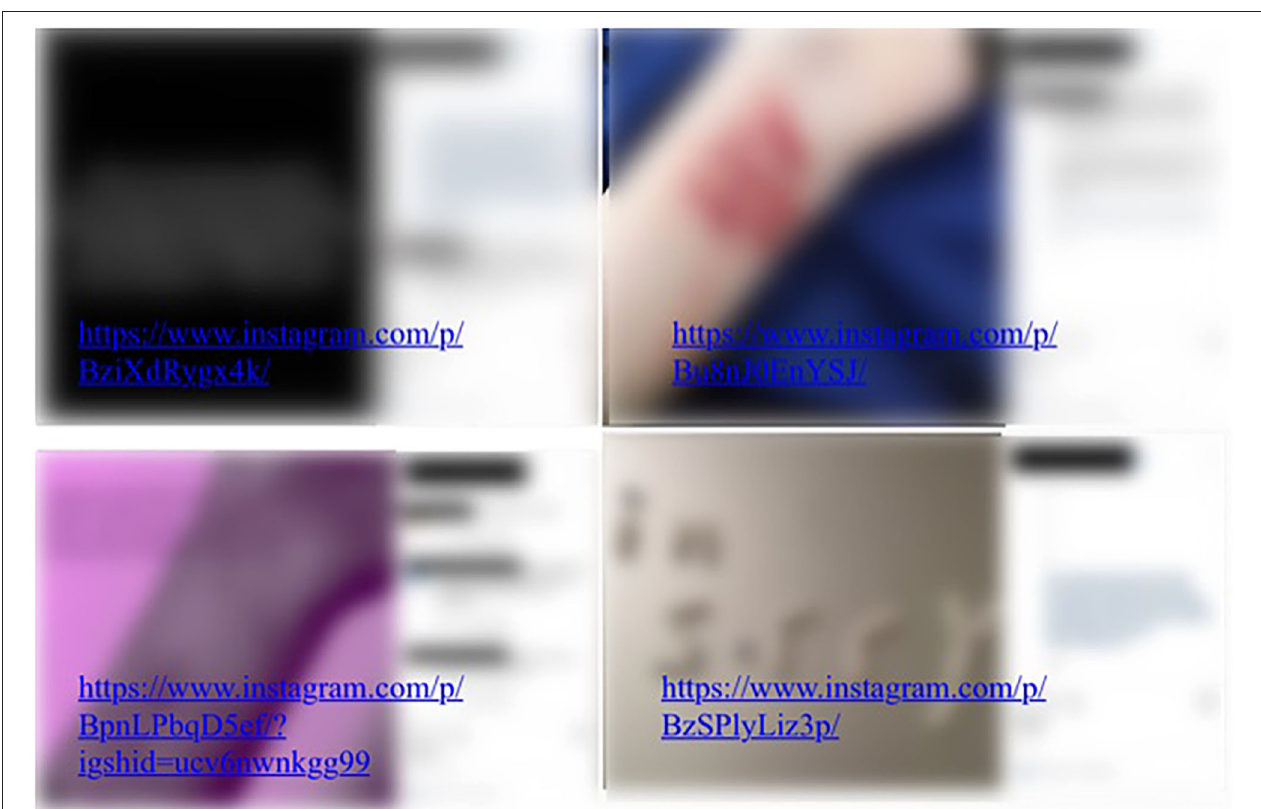
FIGURE 1 | Instagram posts with signal for suicide/self-harm, mental health problems and drug abuse (user information concealed and images blurred). If you’re thinking about suicide, are worried about a friend or loved one, or would like emotional support, please contact the National Suicide Prevention Lifeline at 1-800-273-TALK(8255). Available 24 h (https://suicidepreventionlifeline.org/).